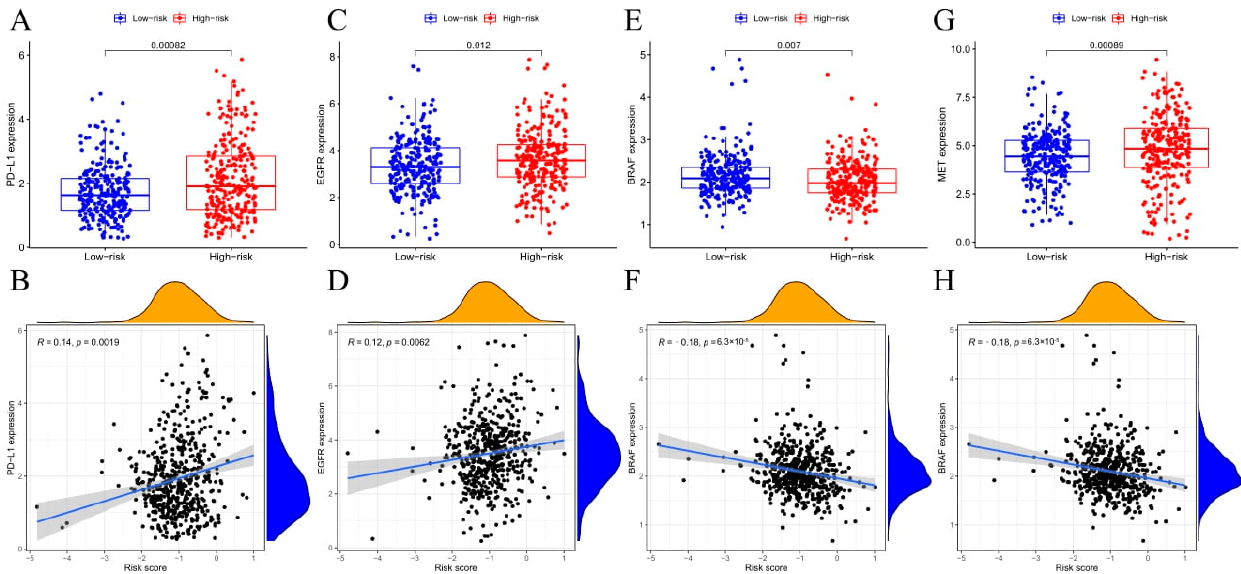
Figure 6. PD-1, EGFR, BRAF, and MET levels compared in the two risk groups and correlations of the risk score with PD-1, EGFR, BRAF, and MET levels. ( A , B ) PD-1. ( C , D ) EGFR. ( E , F ) BRAF. ( G , H ) MET.